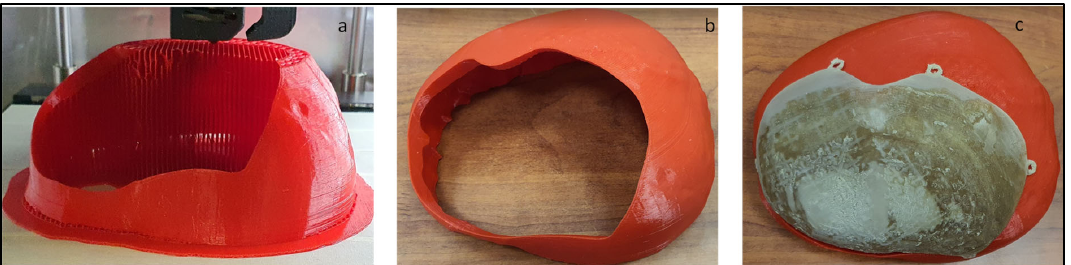
Figure 7. ( a ) 3D printed skull model of the ABS material with supports, ( b ) ABS skull model